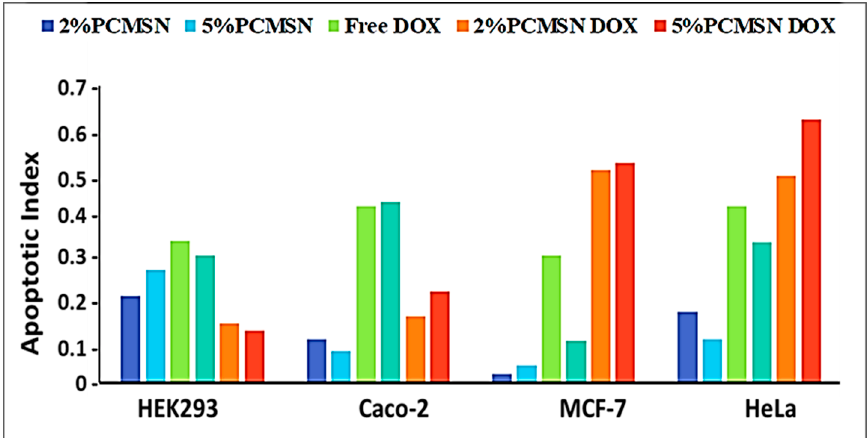
Figure 7. Selected fluorescent micrographs of dual acridine orange / ethidium bromide-stained cells showing induced morphological changes in A ) HEK293 cells, B ) Caco-2 cells treated with DOX loaded 2% PCMSN C ) MCF-7 cells treated with DOX loaded 5% PCMSN, and D ) HeLa cells treated with DOX loaded 5% PCMSN at 20× magnification.